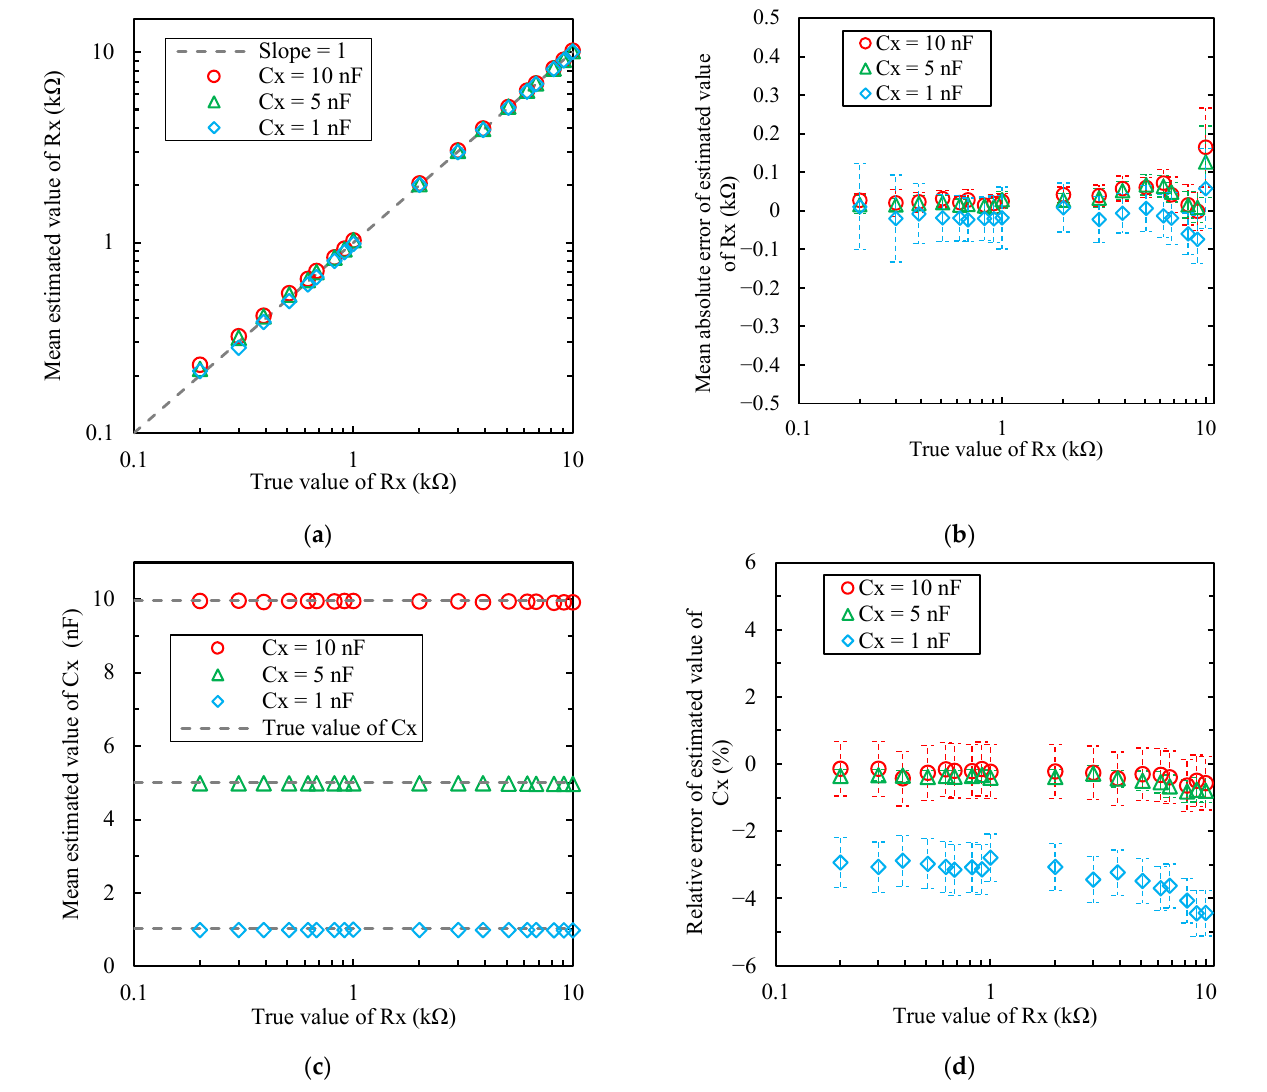
Figure 8. Estimated results of the metal film resistors R x (0.2–10 k Ω ) and polypropylene film capacitors C x (1–10 nF) using the proposed FPGA-based processor: ( a ) mean estimated R x value; ( b ) mean absolute error of the estimated R x value; ( c ) mean estimated C x value; ( d ) relative error of the estimated C x value. Plots and error bars are the mean values and standard deviations within 100 ms obtained using the oscilloscope (12.5 k samples per second).